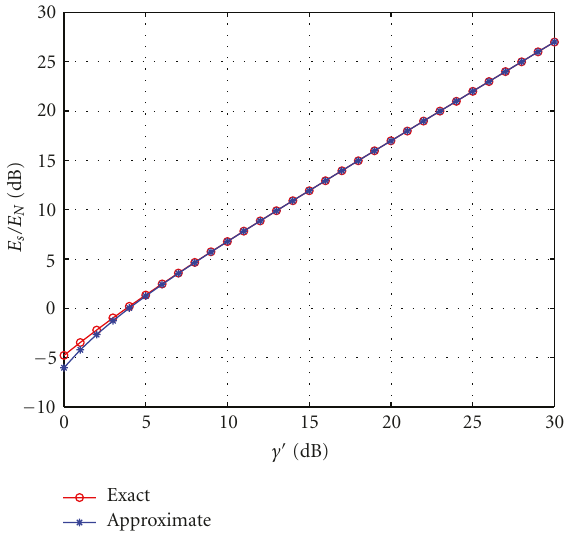
Figure 3: Comparison of approximate and exact SNRs. SNR of DD system is represented by E s /E N and shown over y -axis and SNR of single-di ff erential system is represented by γ (cid:6) and shown over x -